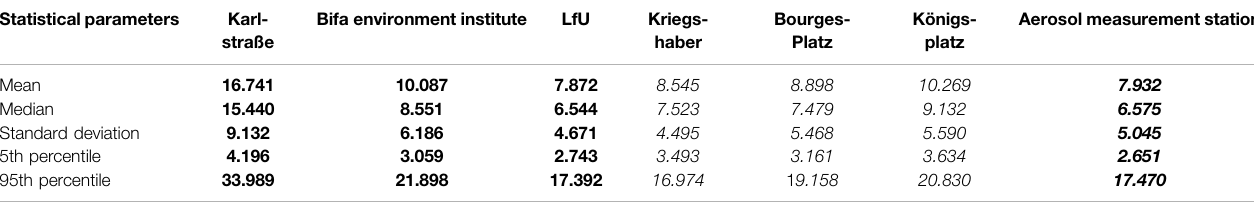
TABLE 3 | Descriptive statistics of the UFP number concentrations in particles/cm 3 (The comparability of the partial non-simultaneous measurement results was assessed beforehand by a sensitivity study indicating that the measurements could be interpreted as annual mean values). Statistical